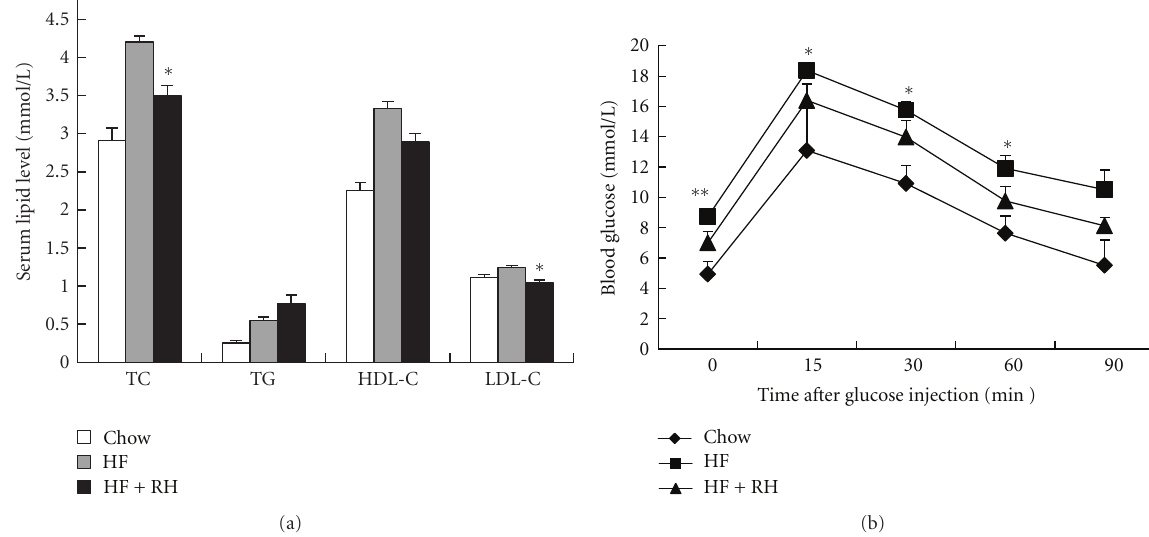
Figure 3: Rhein improves lipid profiles and glucose tolerance test in high-fat diet-induced obese C57BL/6 mice. (a) TC, TG, HDH-c, and LDL-c contents. (b) Fasting blood glucose levels (0min) and glucose tolerance test (GTT). The mice were fasted for 12 hours before measuring blood glucose levels as 0 min. Then 1g/kg body weight of glucose was injected intraperitoneally and glucose levels were tested at regular intervals of 15, 30, 60, and 90 min. Data are presented as mean ± SE for 7 mice per group. HF: high-fat diet. RH: rhein. ∗ P < 0 . 05, ∗∗ P < 0 . 01 versus HF group